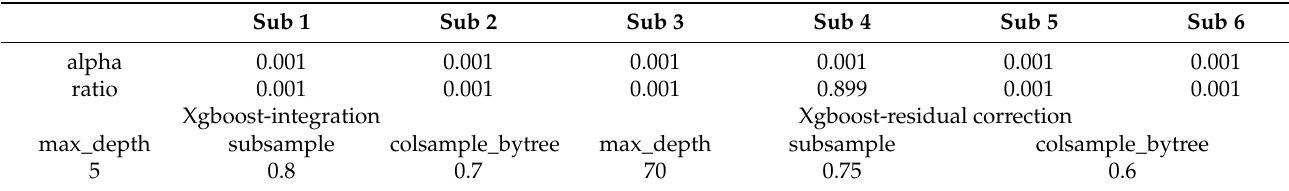
Table 3. Parameters used in case